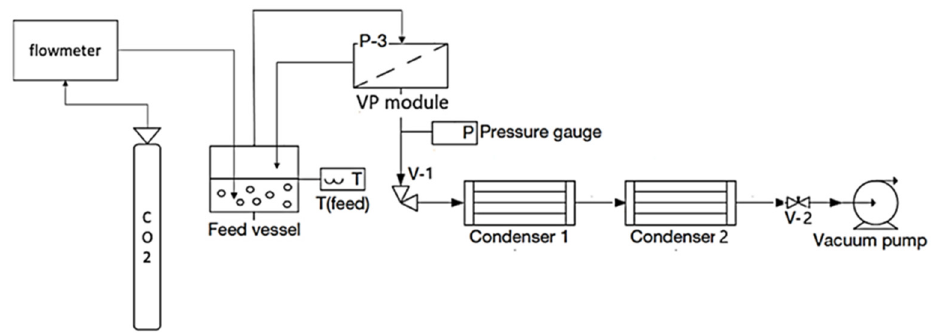
Figure 2. Diagram of the experimental setup of a vapour permeation apparatus with two condensers connected in series.